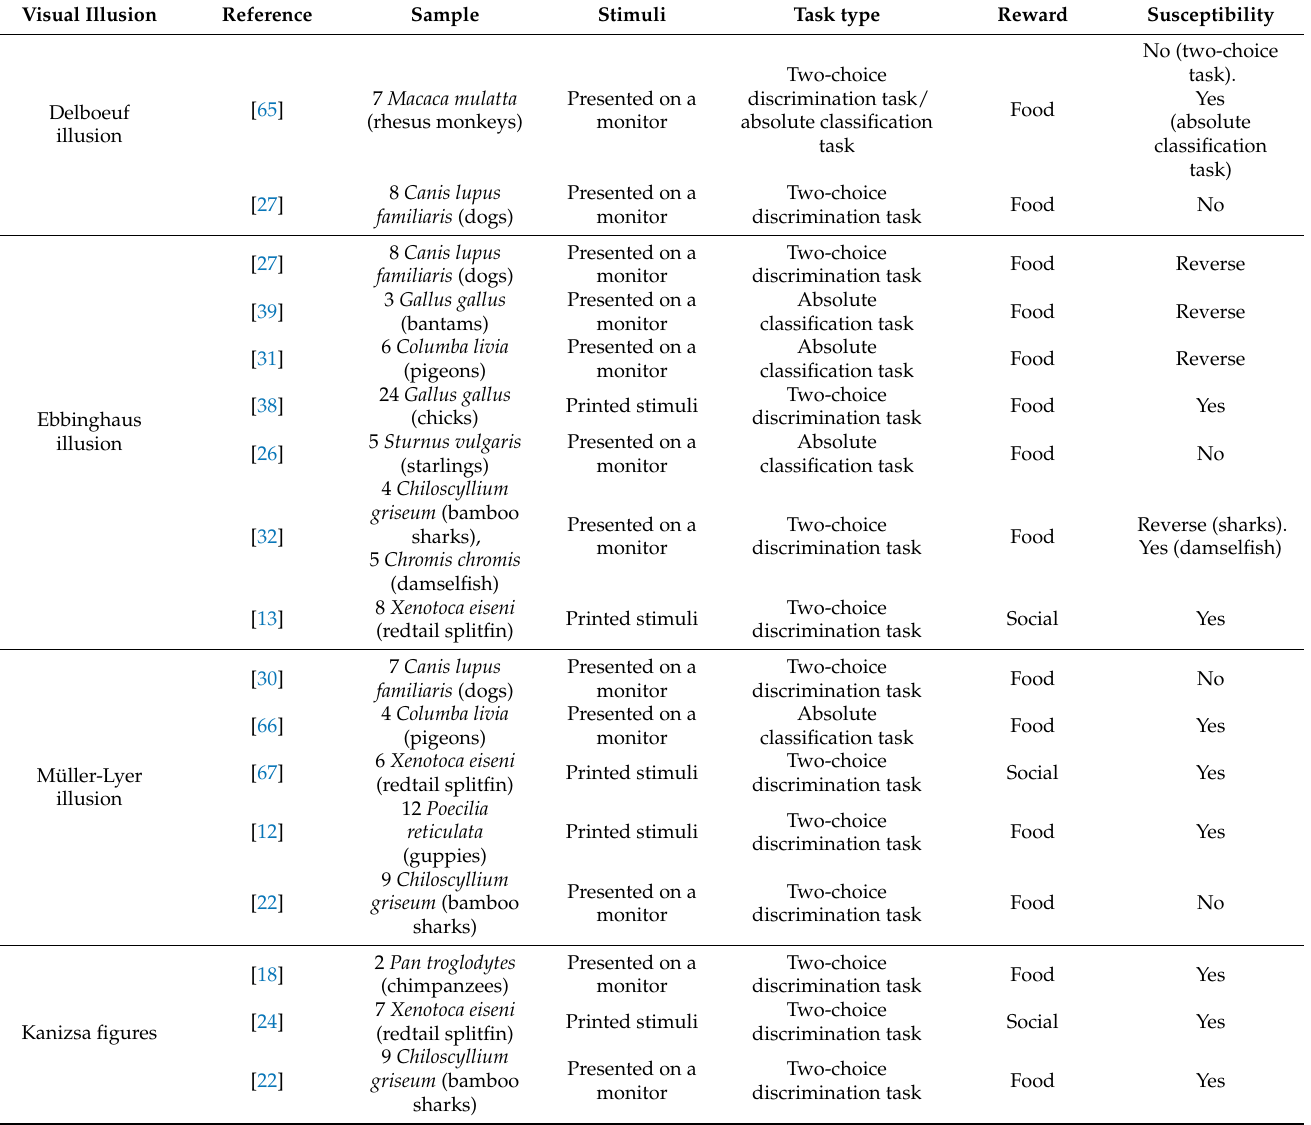
Table 2. Summary of the existing works on visual illusions adopting a training procedure. Visual